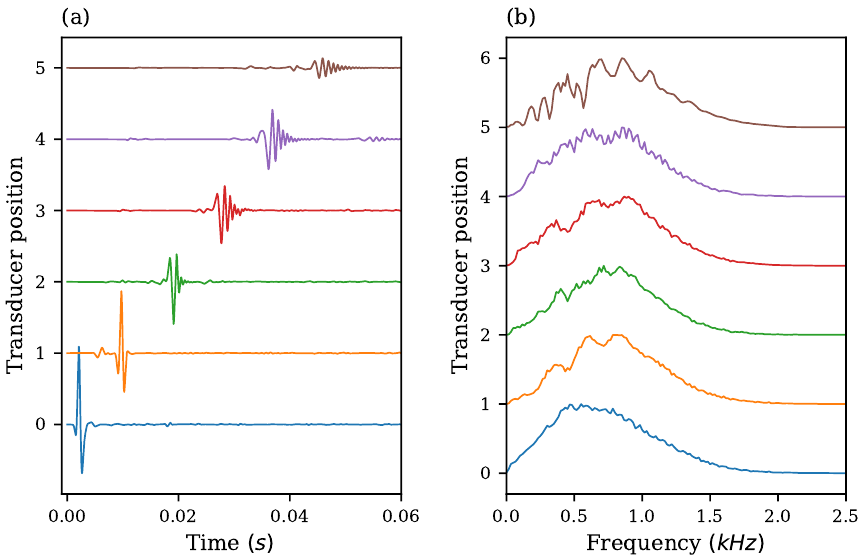
Figure 9. Vertical components of particle velocity, normalized by the peak amplitude of the input signal, recorded in the receivers located at the surface of the dam at different the transducer locations x = [ − 1.5 m, 1.5 m, 4.5 m, 7.5 m, 10.5 m, 13.5 m]: ( a ) Time signal, ( b ) The frequency amplitudes normalized to the peak amplitude of the same signal. (The source is located at x = − 1.5 m).